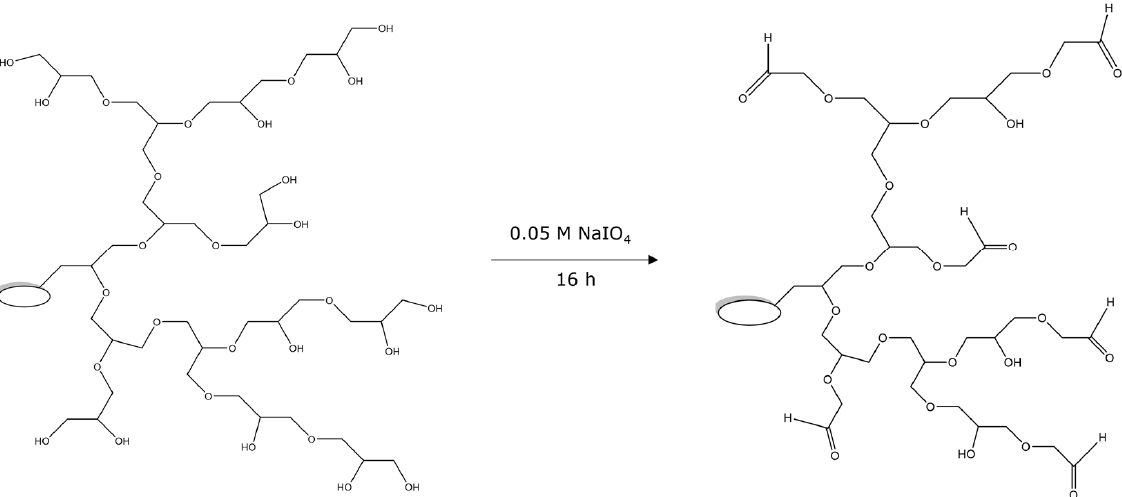
Figure 2. Oxidation of diols in polyglycerol (PG) with sodium periodate. The formation of aldehyde groups could be shown in a 1 H NMR experiment (Supplementary Materials, Figure S8).